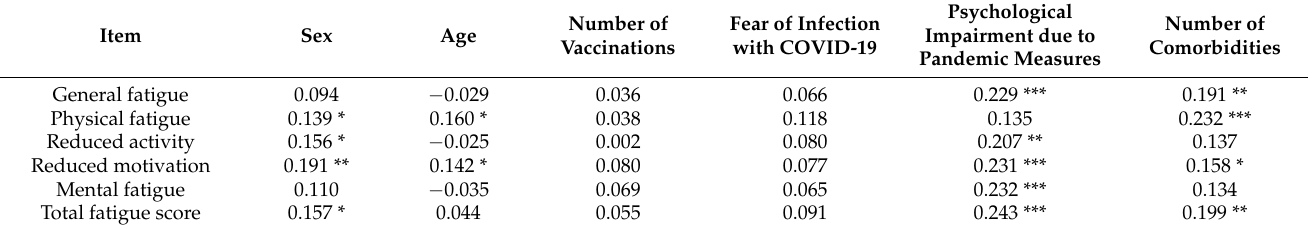
Table 3. Correlations between different fatigue dimensions and sex, age, number of vaccinations against SARS-CoV-2, fear of infection as well as mental impairment due to pandemic measures. Reported as Spearman’s correlation coefficients ρ . ( n =